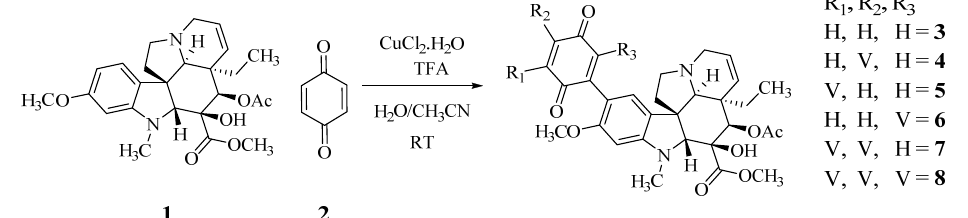
Scheme 3. The preparation of poly-adducts of vindoline and benzoquinone.